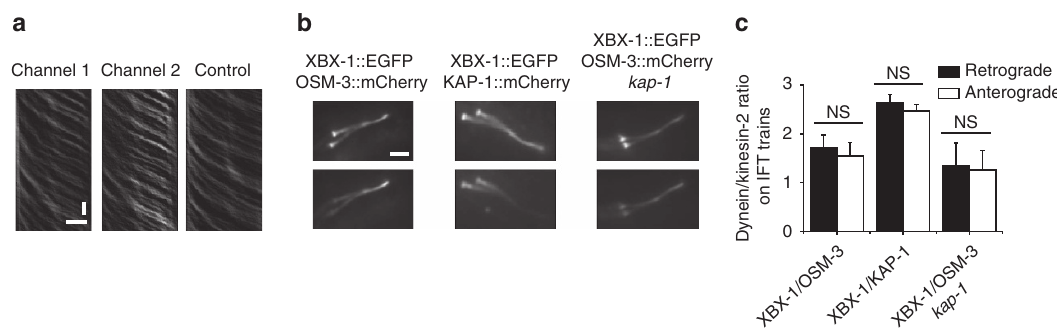
Figure 2 | Directionality is not modulated by the dynein/kinesin-2 ratio. ( a ) Representative Fourier-filtered anterograde kymographs of XBX-1::EGFP (channel 1, M1), OSM-3::mCherry (channel 2, M2) and a randomly chosen control kymograph used for Manders’ colocalization analysis. Time: vertical; scale bar, 2s. Position: horizontal; scale bar, 2 m m. ( b ) Time-averaged fluorescence images of dual-colour strains XBX-1::EGFP OSM-3::mCherry, XBX- 1::EGFP KAP-1::mCherry and XBX-1::EGFP OSM-3::mCherry kap-1 . Scale bar, 2 m m. ( c ) The dynein/kinesin-2 ratio on trains was generated using Fourier- filtered kymographs from dual-colour constructs for each direction of movement (see also Supplementary Fig. 2). A line is drawn along the same train of interest in both channels and corrected for background, photobleaching, bleed-through and excitation intensity. Division of the two corrected position- dependent intensities gives the XBX-1/OSM-3 ratio ( n ¼ 95 trains, 24 worms), XBX-1/KAP-1 ratio ( n ¼ 67 trains from 20 worms) and XBX-1/OSM-3 kap-1 ratio ( n ¼ 56 trains from 14 worms). The XBX-1/OSM-3 ratio was taken in the distal segment region (4.0–7.5 m m) and the XBX-1/KAP-1 ratio in the proximal segment region (0–3.5 m m). Error is s.d. NS, no significant difference, unpaired t -test. See also Supplementary Table 3 and